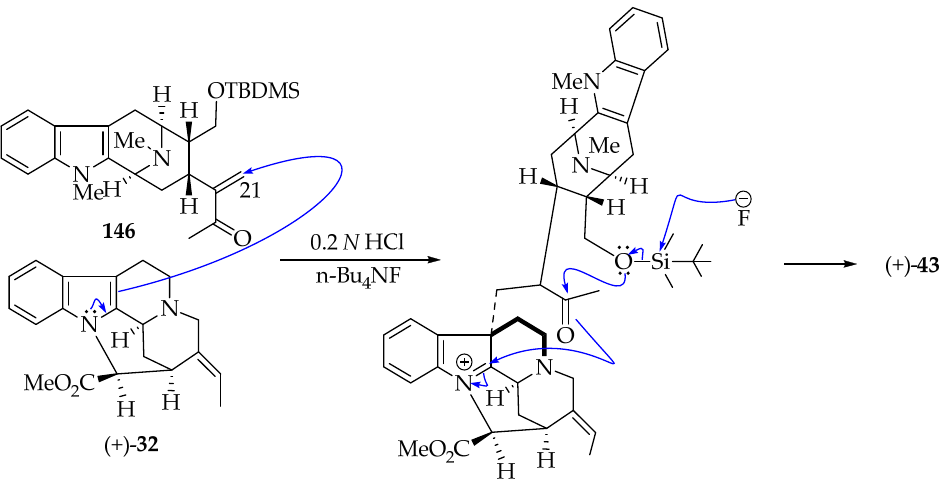
Figure 8. Representative examples of C-19 methyl-substituted monomeric sarpagine/macroline-related alkaloids from Al- stonia species and their